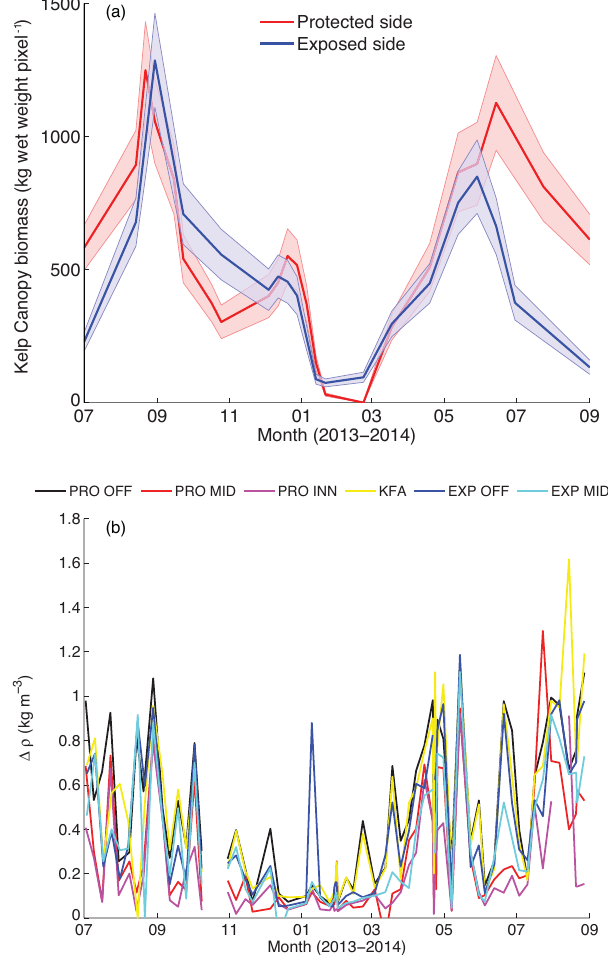
Figure 2. Time series of (a) satellite-derived kelp canopy biomass per 30m × 30m satellite pixel for the protected and exposed sides, and (b) (cid:49)ρ for all six sites. The shaded bars in (a) show the 95% confidence interval of the kelp canopy biomass estimate.